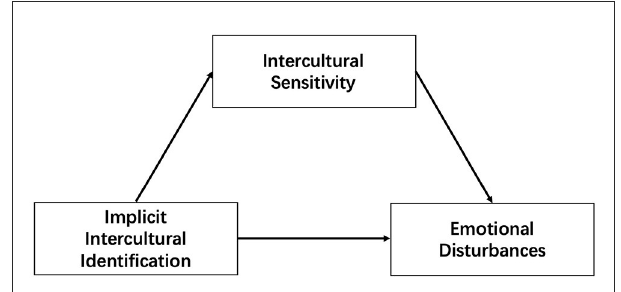
FIGURE1 Proposed model for the relationship among implicit intercultural identification, intercultural sensitivity, and emotional